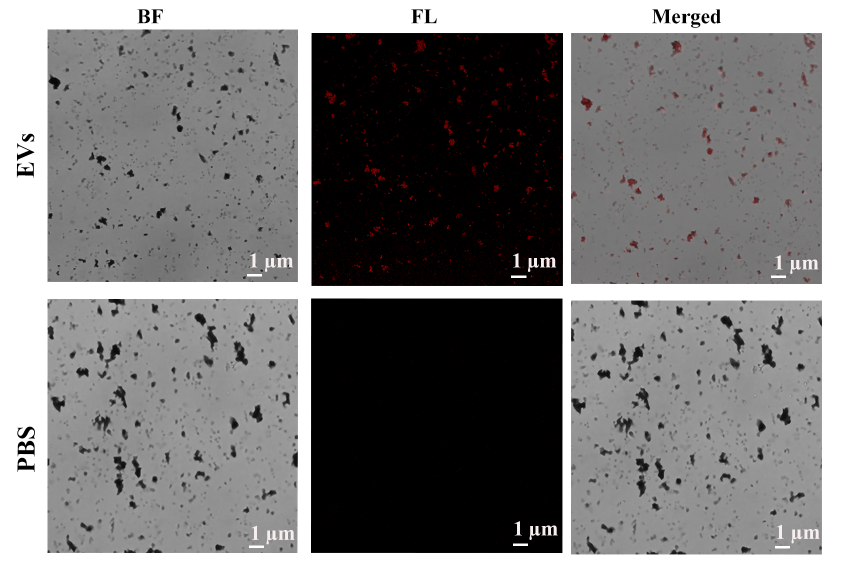
Figure 4. Confocal microscopy-based visualization of the PD-L1@EVs by Cy3-PD-L1 aptamer. BF (Bright filed), FL